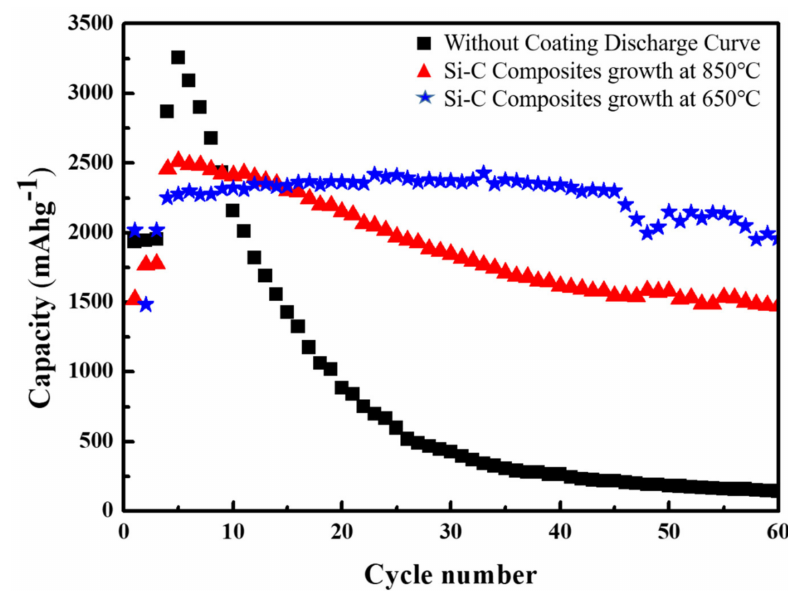
Figure 11. Comparison of cycling performance of lithium ion battery (LIB) anodes made of (black curve) as-received silicon flakes, (red curve) silicon flakes with nanocarbon coating at 850 ◦ C, and (blue curve) silicon flakes with nanocarbon coating at 650 ◦ C. The discharging/charging rate is 0.01 C for the first three cycles and 0.1 C for remaining cycles.